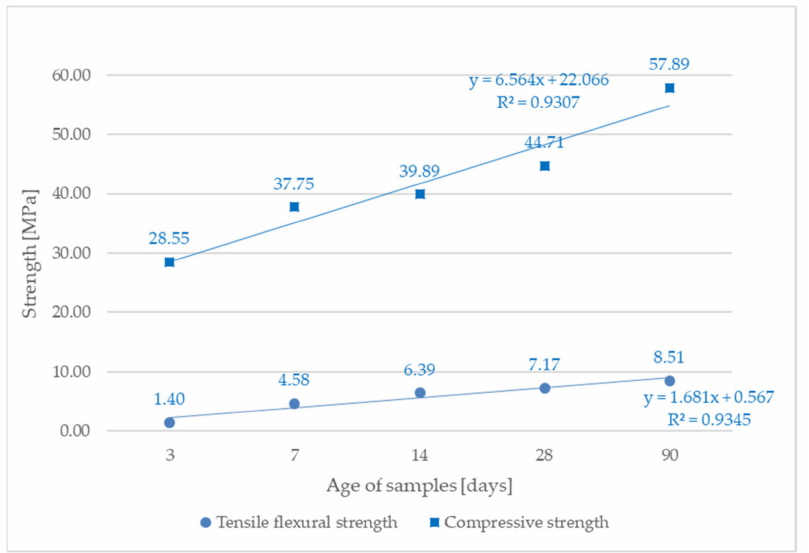
Figure 3. Tensile flexural strength and Compressive strength of comparative mixture.